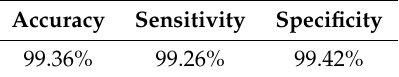
Table 3. CNN results for experiment number 2 in terms of Accuracy, Sensitivity and Specificity. The metrics are evaluated on the Taranto dataset, averaging the scores obtained by the 5 CNNs (trained for the k-fold cross validation strategy) on the 20% portion of the dataset left for the validation.